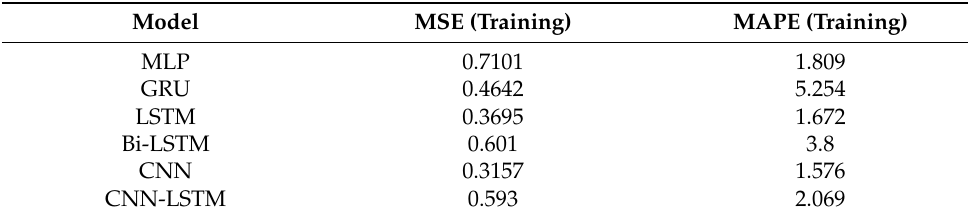
Table 4. The training results of the models using Tesla data with four input features.